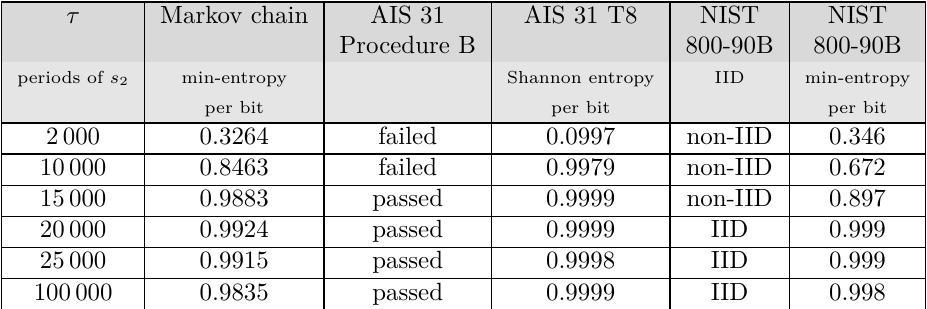
Table 10: Entropy estimation using high order Markov chains, AIS 31 and NIST 800-90B tests, when two internal STRs and the least significant bits of the first differences of counter values were used. Dependencies are modeled using 8 th order Markov